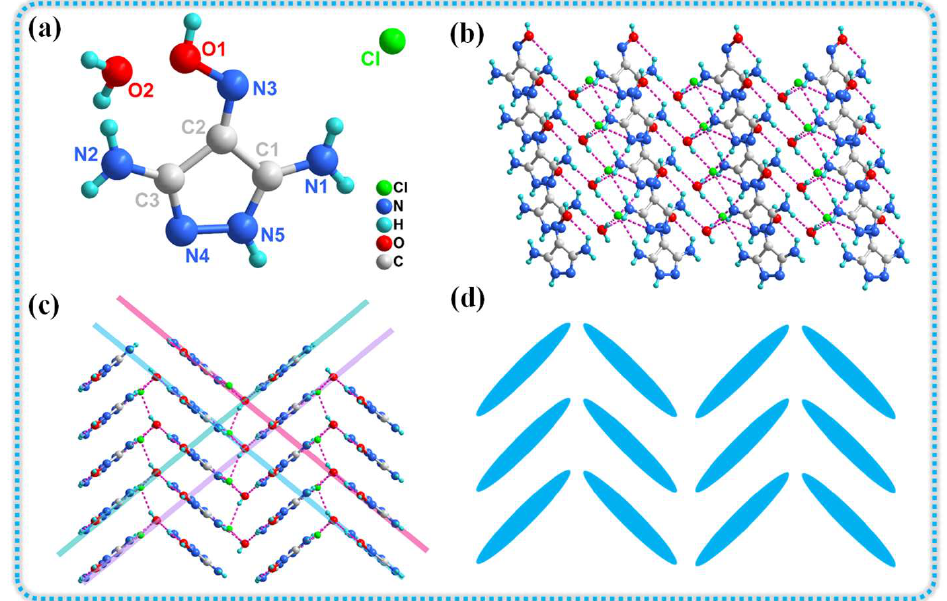
Figure 2. ( a ) Molecular structure of DAPOC · H 2 O; ( b ) Hydrogen bonding network and 2D layer structure of DAPOC · H 2 O; ( c ) The arrangements of layer for DAPOC · H 2 O; ( d ) Crystal stacking of DAPOC·H 2 O.